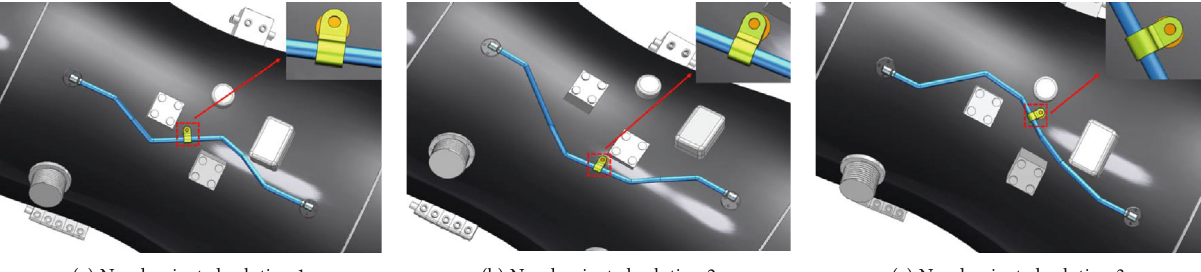
Figure 10: Visualization of routing example.